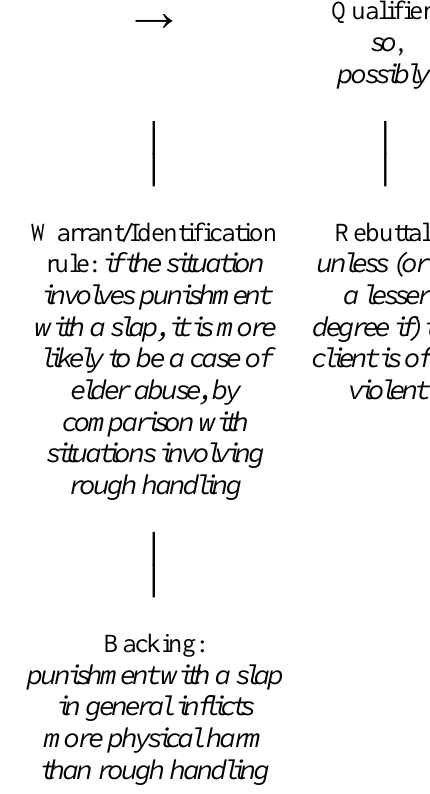
A model of discretionary reasoning based on fictive results from a factorial survey on elder abuse (research design by Killick & Taylor, 2012)* Data